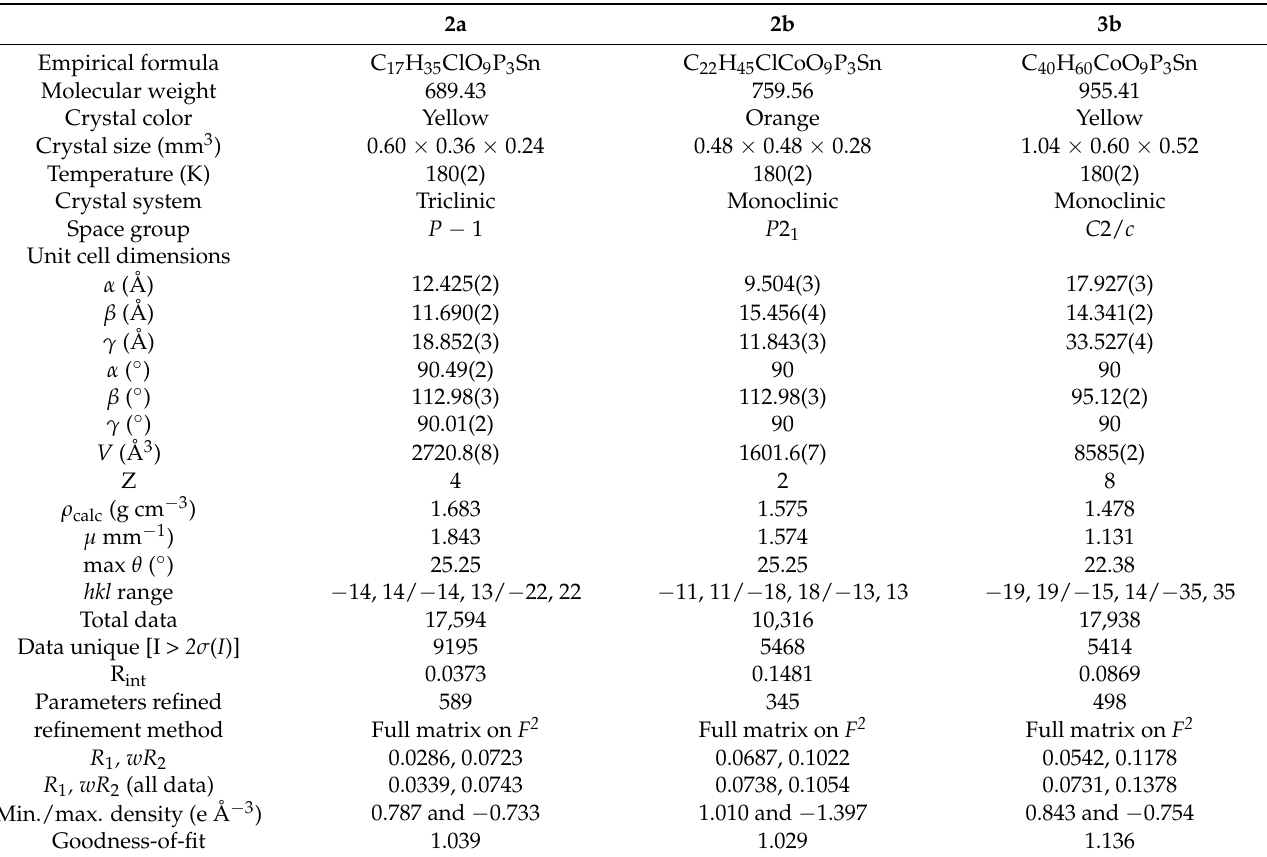
Table 2. Summary of crystallographic data for the complexes 2a , 2b and 3b